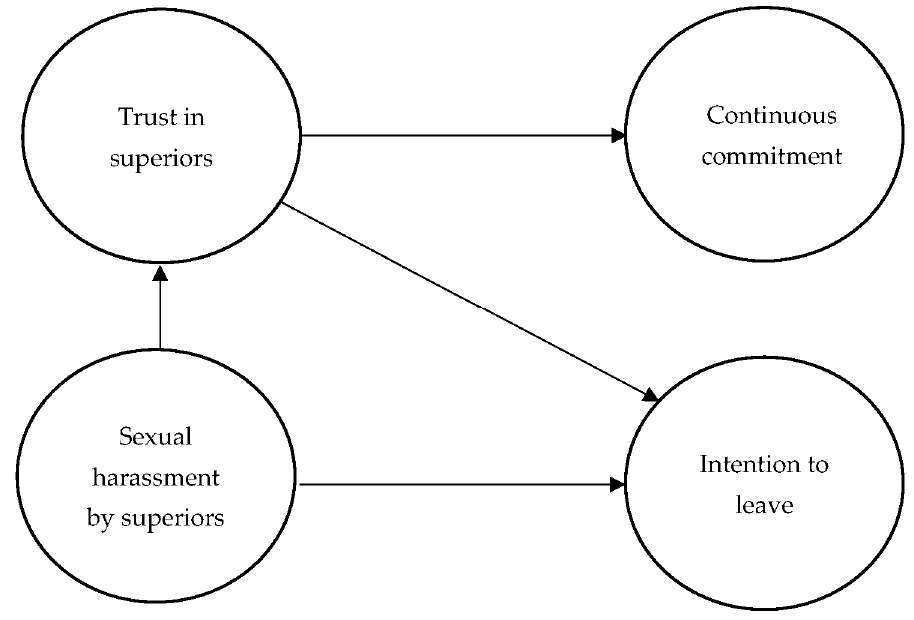
Figure 1. The research conceptual